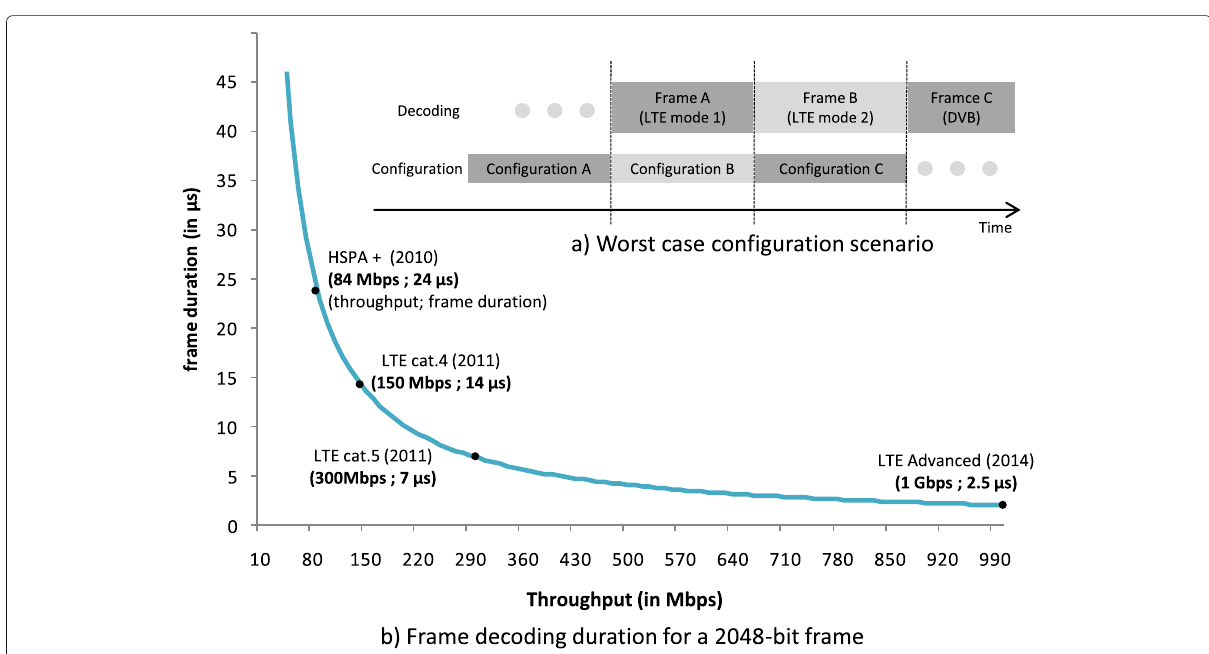
Fig. 1 Decoding latency of a 2048-bit frame. a Worst-case configuration scenario. b Frame decoding duration for a 2048-bit